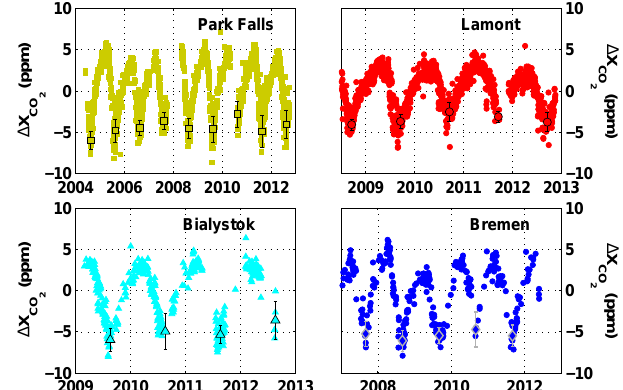
Fig. 2. The time series in Fig. 1 detrended to show the seasonal . The symbols show the drawdown values and their cycle in 1 X CO 2 seasonal cycle minima 1 σ error bars. The 2007 and 2010 1 X CO 2 are relatively weak compared with those in 2008 and 2009.